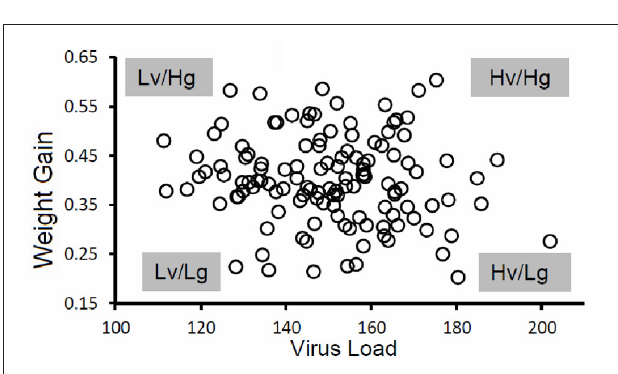
FIGURE 3 | Virus load versus weight gain. The figure shows results for a single trial. The virus load was calculated as the area under the curve for viremia over the first 21 days for each pig as described in Figure 1 . Average daily gain was calculated as the weight at 42 days after infection minus the weight on the day of virus challenge divided by 42 days. Key: Hv, high virus load; Lv, low virus load; Hg, high weight gain; Lg, low weight gain. Virus load for each pig was determined by calculating the area under the curve for the first 21 days after